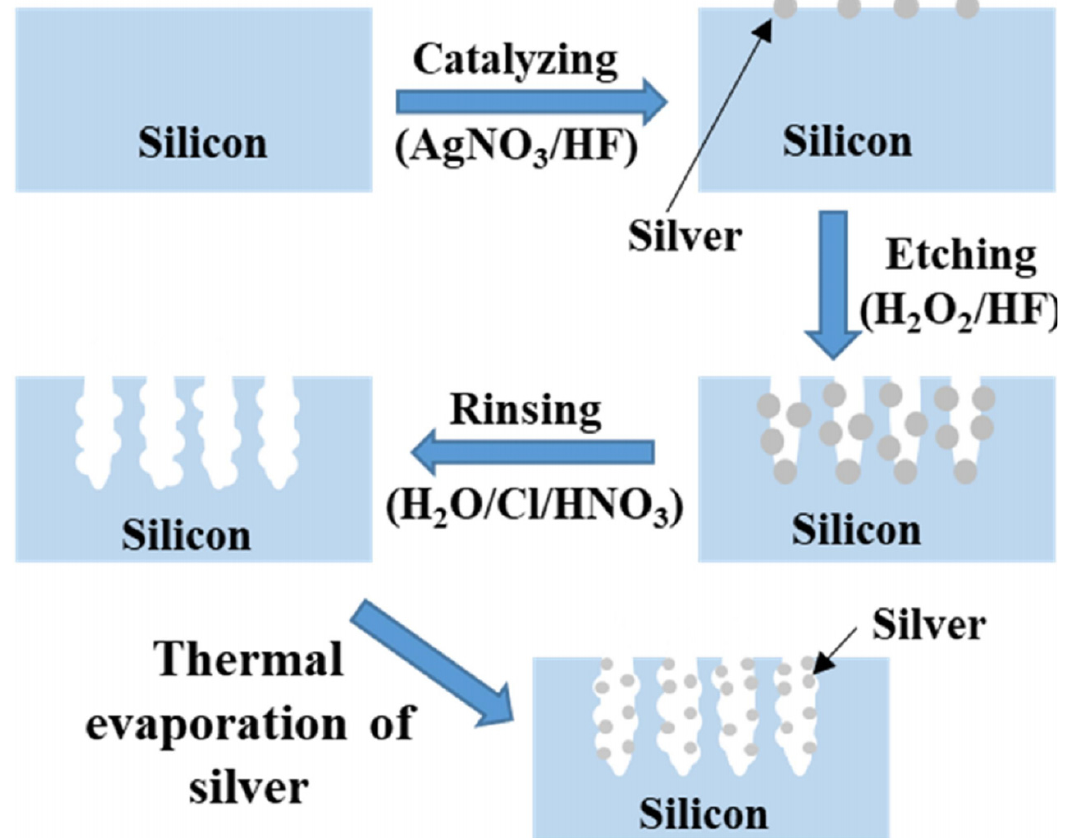
Figure 6. Free-hand schematic depicting the involved steps (i.e., catalyzing, etching, rinsing, and evaporation) in achieving Ag-decorated terraces in Si-NSs from a clean Si wafer. evaporation) in achieving Ag-decorated terraces in Si-NSs from a clean Si